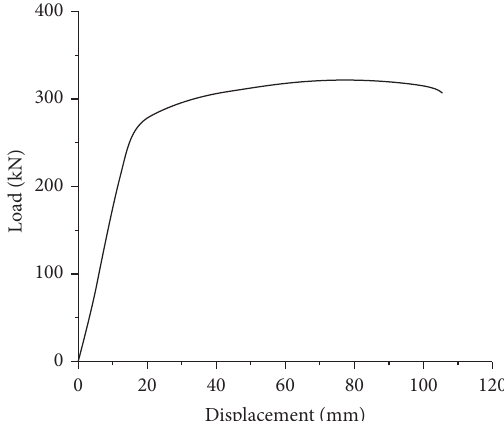
Figure 4: Load-displacement curve of stainless steel bars.